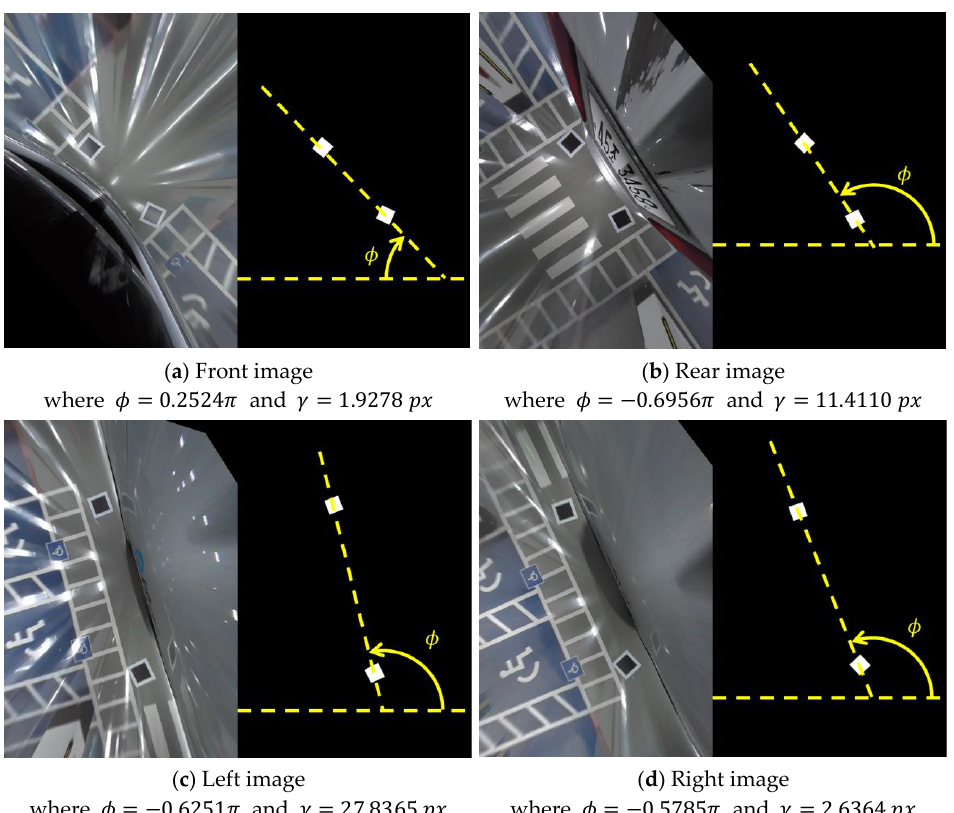
Figure 12. The results of the proposed method.